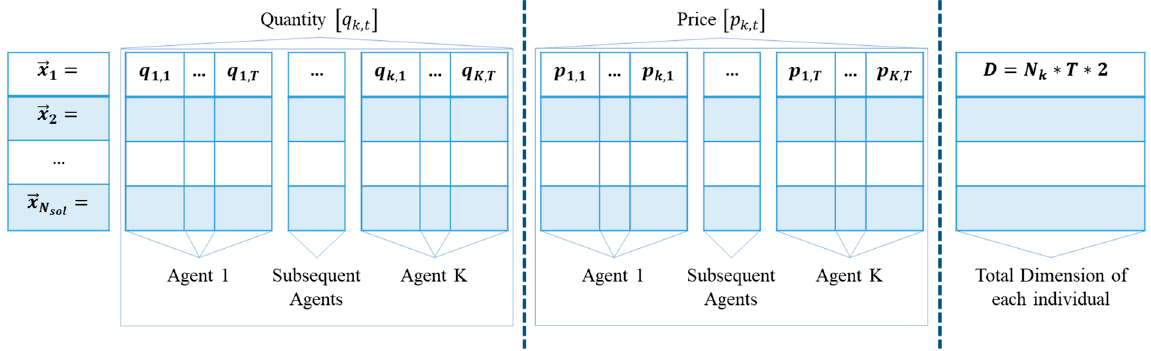
Figure 3. Solution representation track 1.